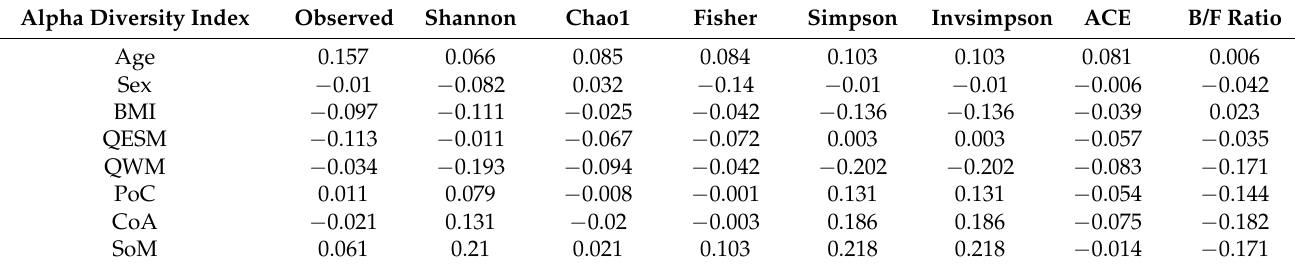
Table 2. Association between alpha diversity indices, demographics and cognition.